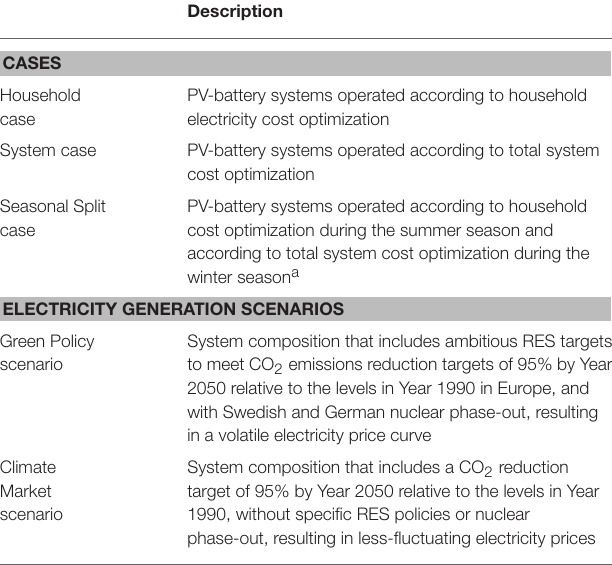
TABLE 1 | Summary of cases and scenarios considered in the